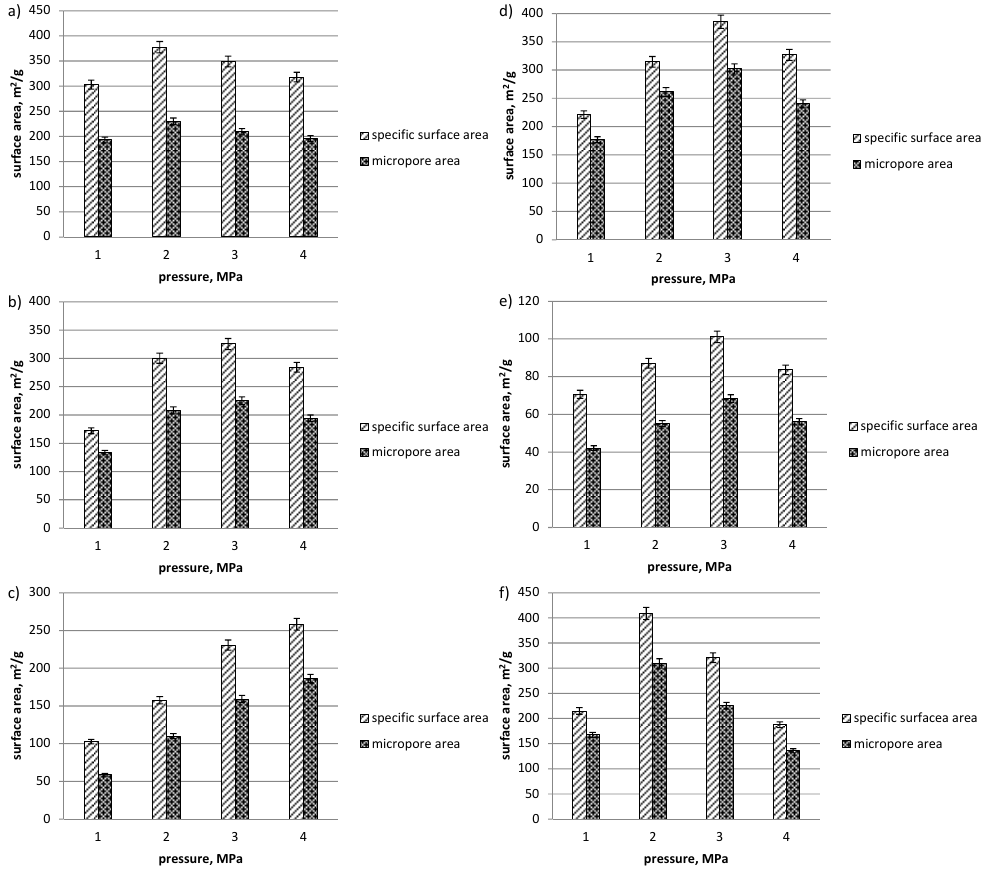
Figure 2. Variation in pore surface area of chars: ( a ) object 1; ( b ) object 2; ( c ) object 3; ( d ) object 4; ( e ) object 5; and ( f ) object 6 with pressure applied in pyrolysis.